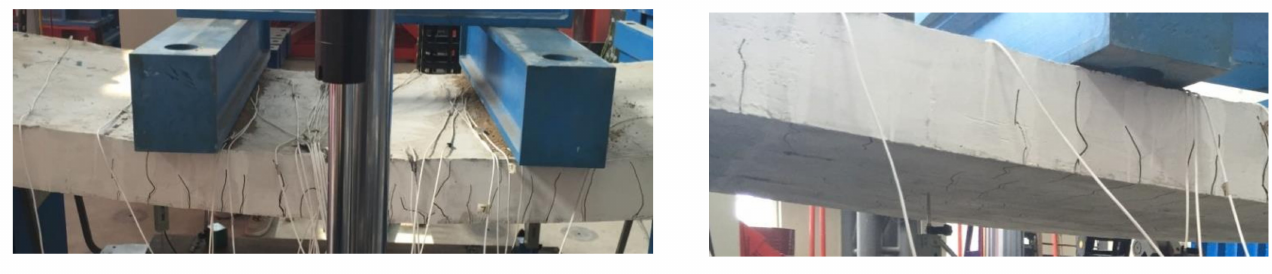
Figure 14. Crack distributions of composite slabs in tests.